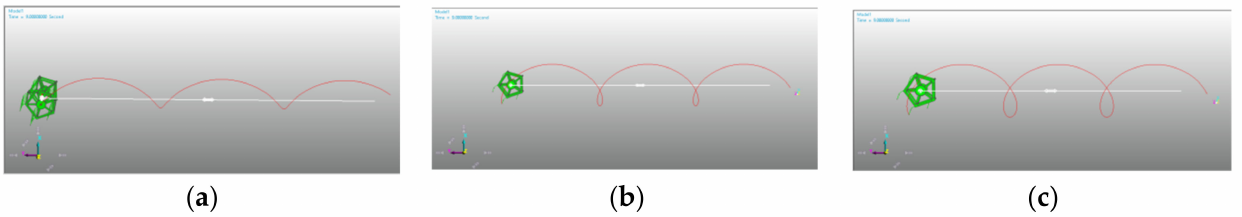
Figure 3. Simulation track diagram of pulling reel. ( a ) The λ < 1 movement trajectory; ( b ) The λ = 1 movement trajectory; ( c ) The λ > 1 movement